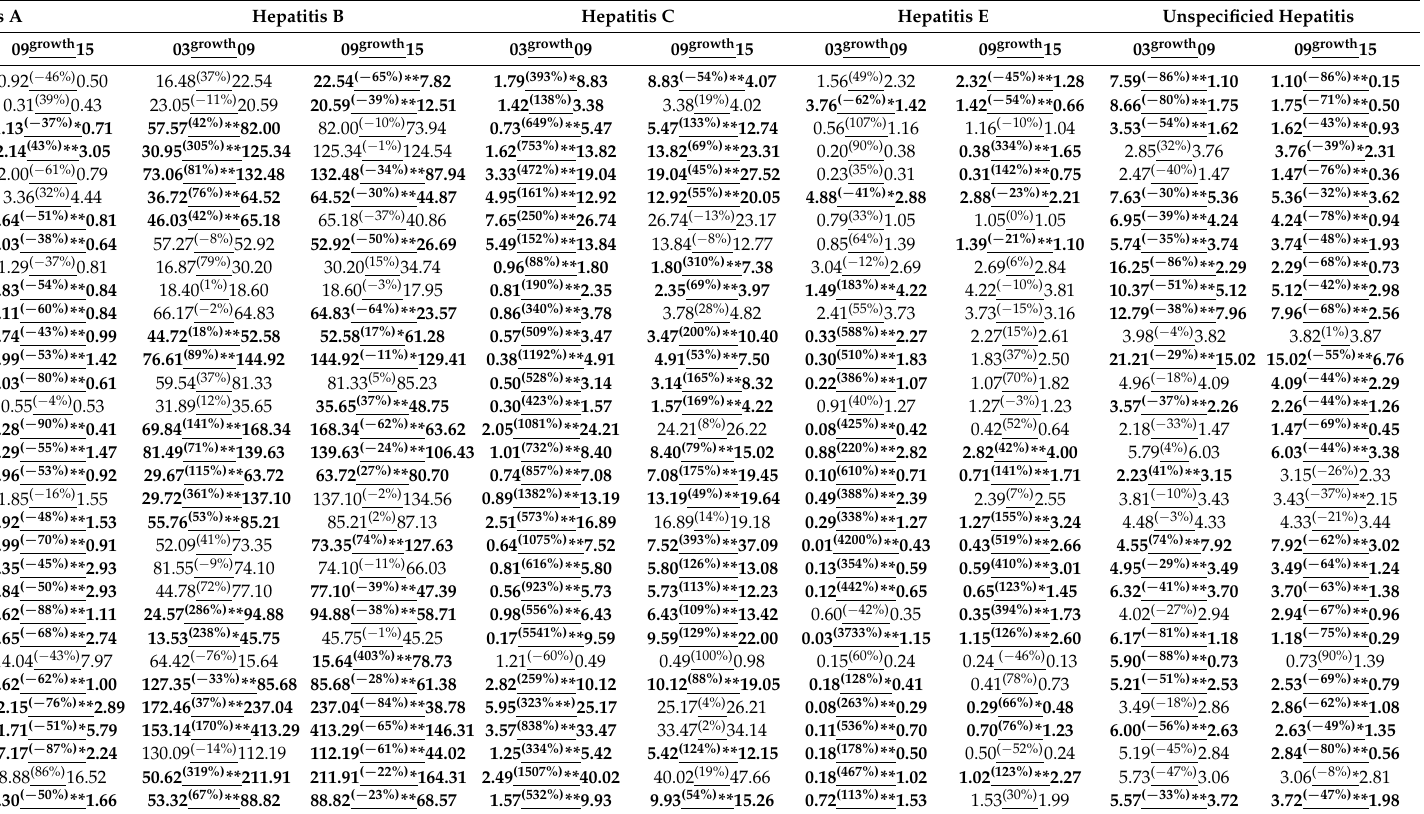
Table 1. Growth of incidence of viral hepatitis in China and linear test (1/100,000) 1